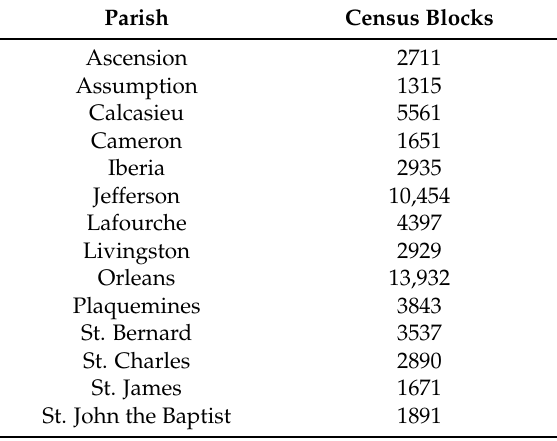
Table 1. Twenty coastal parishes in the study area and the count of constituent census